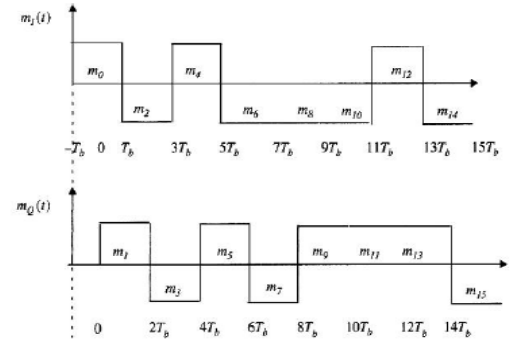
Fig. 5. Staggering of the In-phase and Quadrature modulated bit streams in OQPSK.